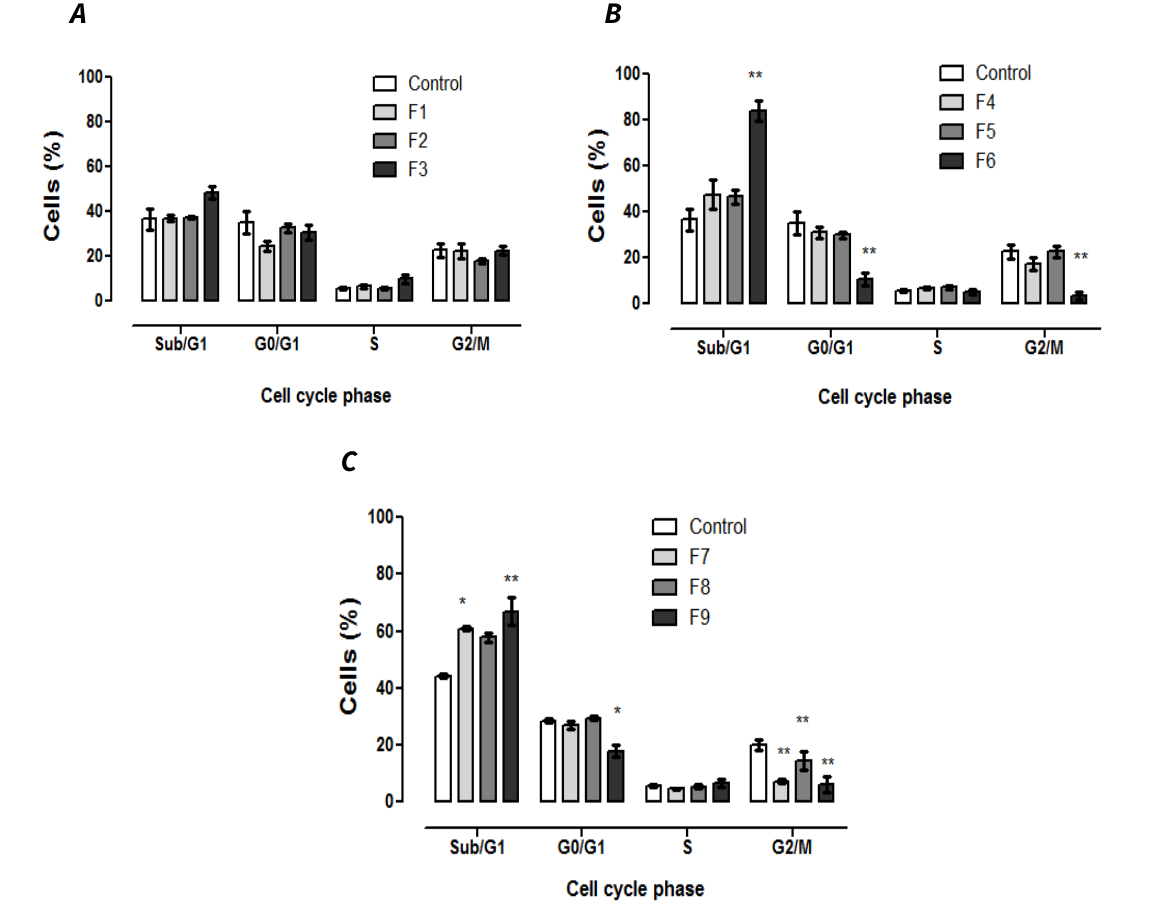
Figure 3. Fibroblasts cell cycle analysis after 24 h of exposure to formulations. The percentage of cells in each phase of the cell cycle stained with PI solution (2 μg·mL −1 ) and analyzed by flow cytometry. ( A ) Formulations containing tripalmitin as matrix lipid; ( B ) formulations containing glycerol monostearate as matrix lipid; and ( C ) formulations containing stearic acid as matrix lipid. Data are expressed as mean ± SE of 3